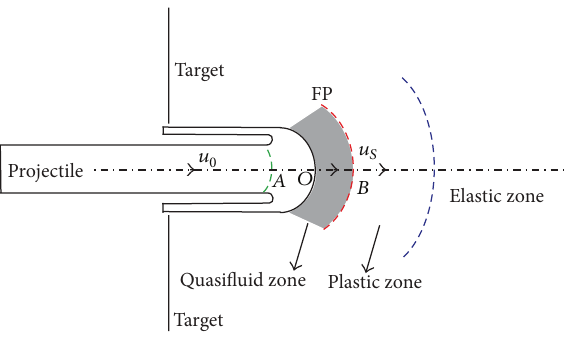
Figure 6: Response regions along the centerline in the target under high impact